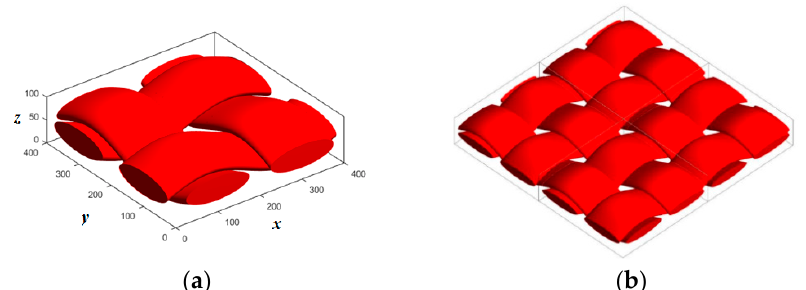
Figure 1. The bunched fiber sample of carbon cloth gas diffusion layer (GDL). ( a ) A primitive cell of carbon cloth GDL and ( b ) the concatenation of primitive cells.